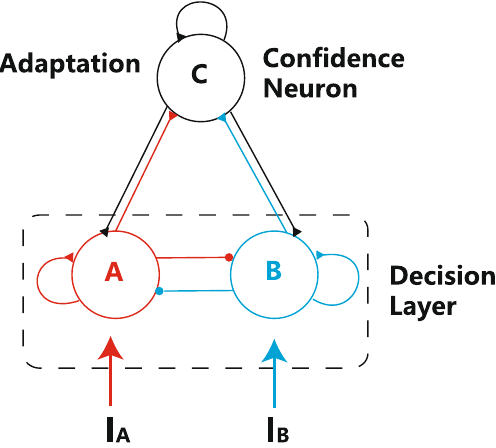
Figure 1. Model structure. The model consists of a decision layer and a confidence neuron pool. The decision layer follows the classical decision circuit 22,23,27 . The adaptive confidence neurons receive the feedforward input from two competing neuron pools in the decision layer and send the feedback projections to the decision layer.